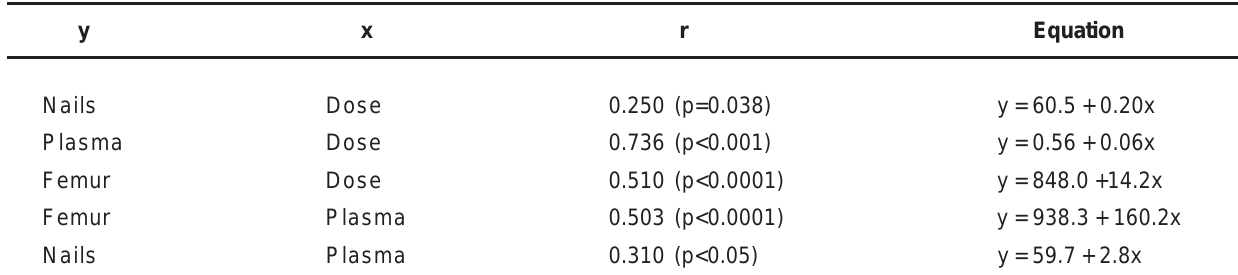
Values in the same column with the same superscripts are not statistically significant (p<0.05). TABLE 2- Correlation between fluoride concentration (ppm) in nails, femur, and plasma and fluoride dose administered (mg/kg body